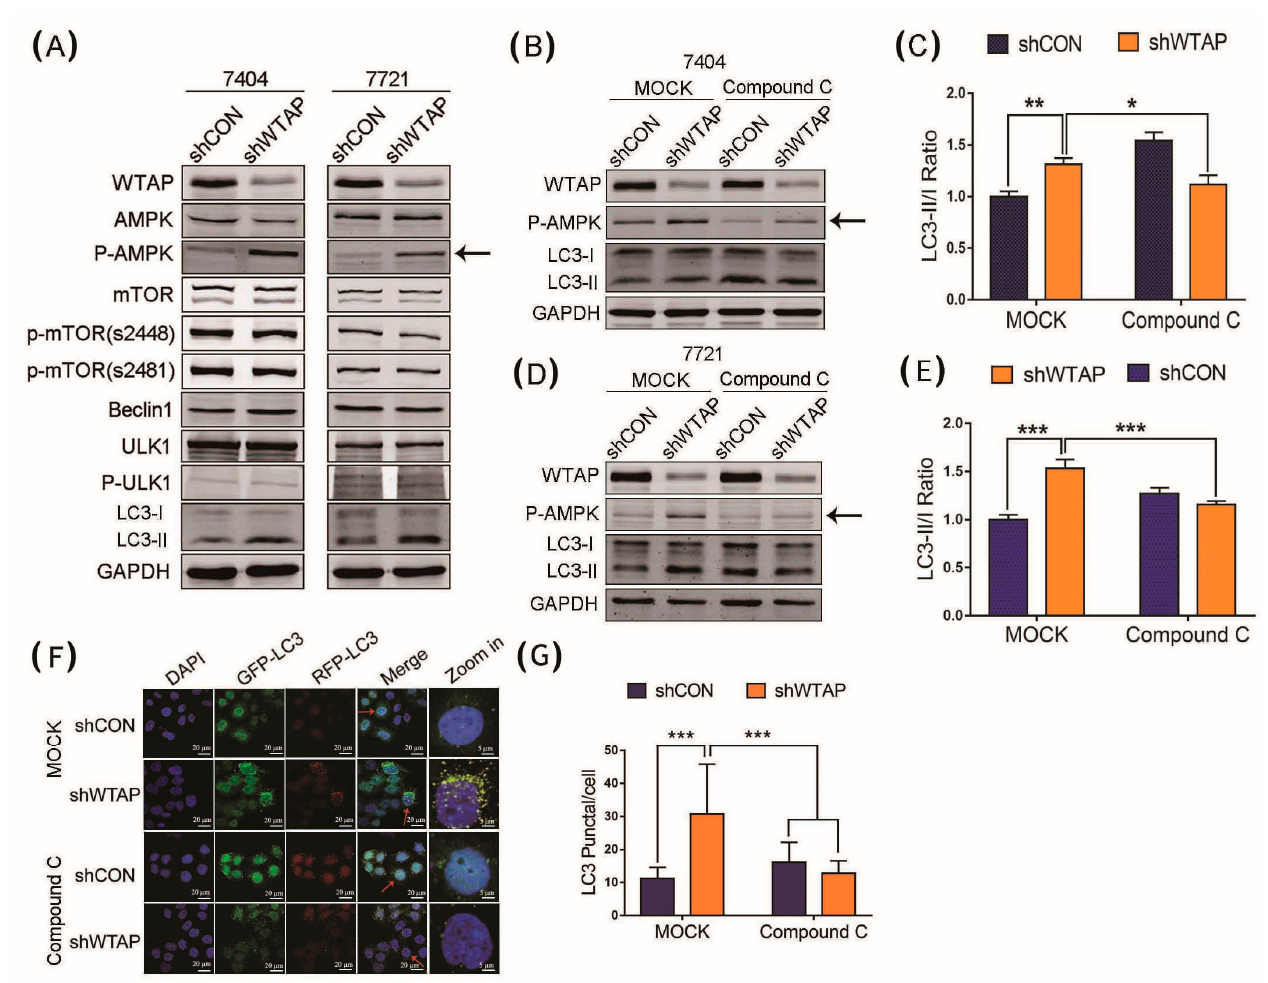
Figure 3. Effect of the upregulated level of p-AMPK caused by shWTAP on HCC autophagy. ( A ) Western blot analysis of some autophagy-related proteins expressed in BEL-7404 and SMMC-7721 cells. ( B ) Western blot analysis of LC3-I and LC3-II in shWTAP BEL-7404 cells treated with or without Compound C. ( C ) Western blot analysis of LC3-I and LC3-II in shWTAP BEL-7721 cells treated with or without Compound C. ( D ) Statistical analysis of LC3 II/LC3 I ratio between shCON and shWTAP–treated 7404 cell lines. ( E ) Statistical analysis of LC3 II/LC3 I ratio between shCON and shWTAP-treated 7721 cell lines. ( F ) Confocal fluorescence image of shWTAP cells treated with or without Compound C. ( G ) Statistical analysis of the numbers of LC3 puncta/cell. The cells indicated with red arrows were enlarged on the right. Error bars indicate the mean ± SD from three independent experiments ( n = 3). * indicate a statistically significant difference ( p < 0.05), ** indicate a statistically significant difference ( p < 0.01) and *** indicate a statistically significant difference ( p < 0.001).